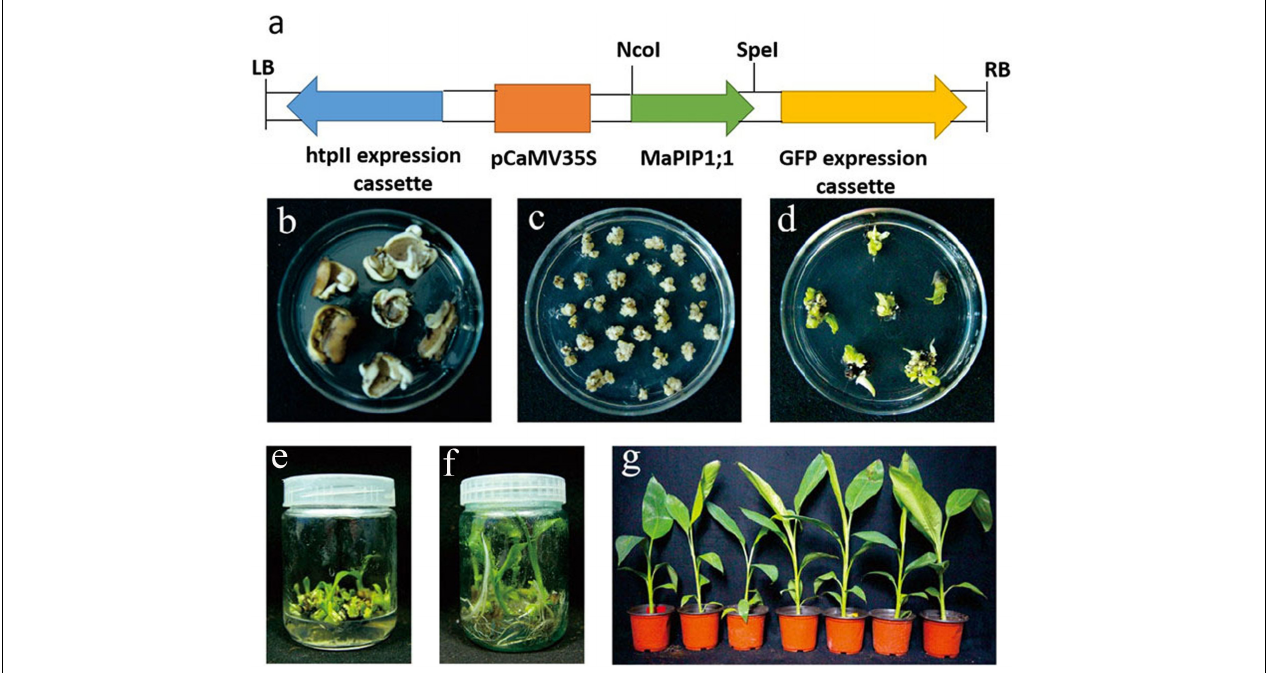
FIGURE 1 | Generation of MaPIP1;1 overexpressing banana plants. (a) Schematic representation of T-DNA region used to generate transgenic plants. (b) Slices of the floral apex on differentiation medium. (c) Callus regenerated from slices. (d) Conversion of callus into shoots on shooting medium. (e) Generation of multiple shoots of putative transgenic lines. (f) Rooting of different transgenic lines on rooting medium. (g) Hardening of rooted transgenic lines.